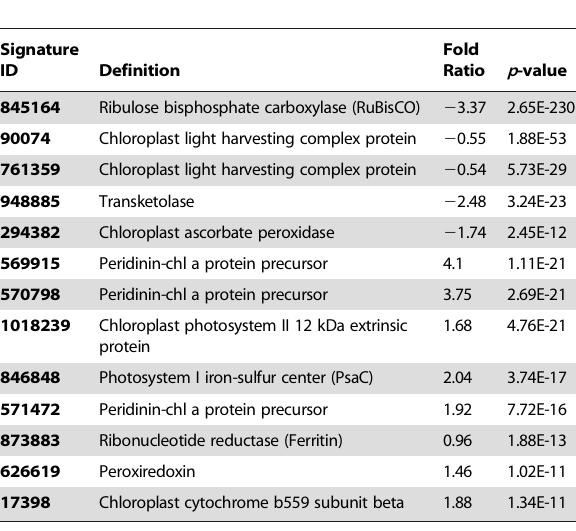
Table 4. Photosynthesis-related genes that are significantly differentially expressed in the presence of